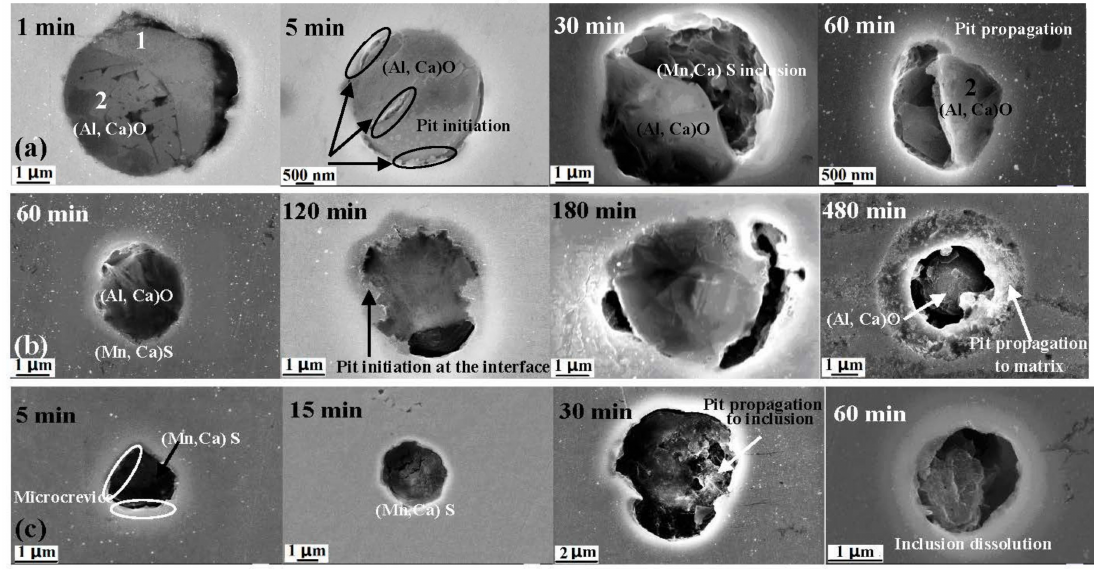
Figure 7. SEM images of three types of inclusions after initiation and propagation of pitting corrosion in X70 steel: ( a ) Type A; ( b ) Type B and ( c ) Type